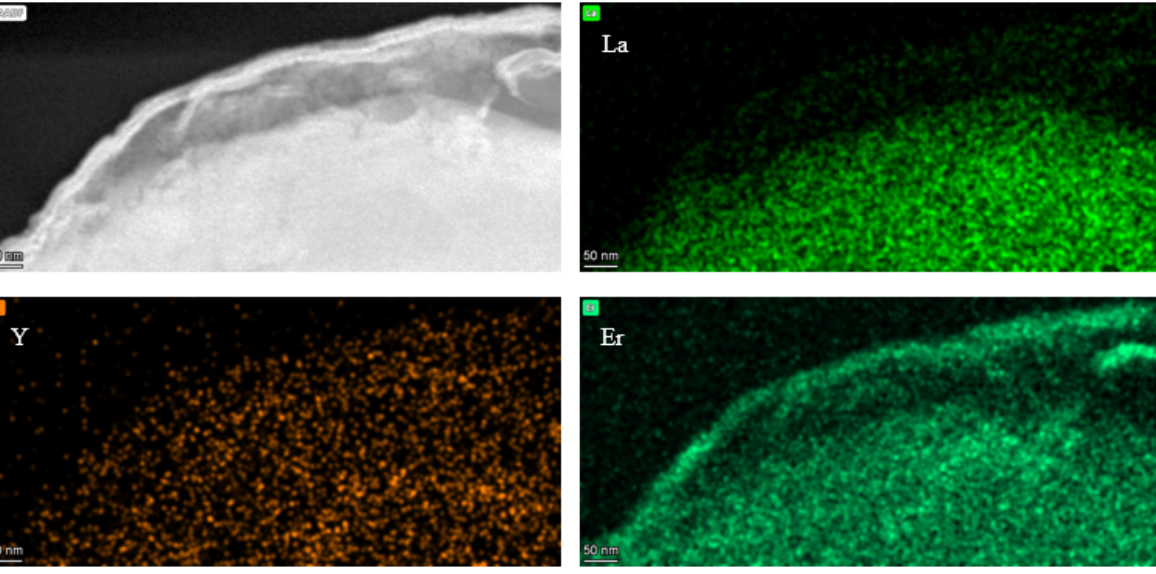
Figure 10. Area 1213. Clockwise from upper left: HAADF image; La element map; Er element map; and Y element map.